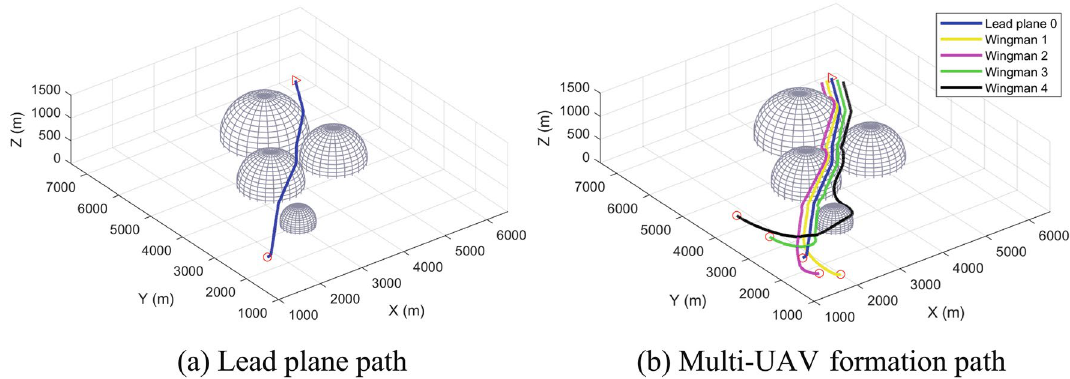
Figure 10. Multi-UAV path planning in a space with obstacles.